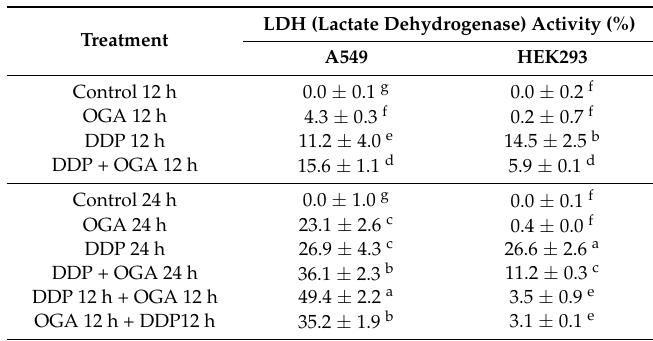
Table 2. Cytotoxicity of DDP and OGA on human A549 cancer cells.